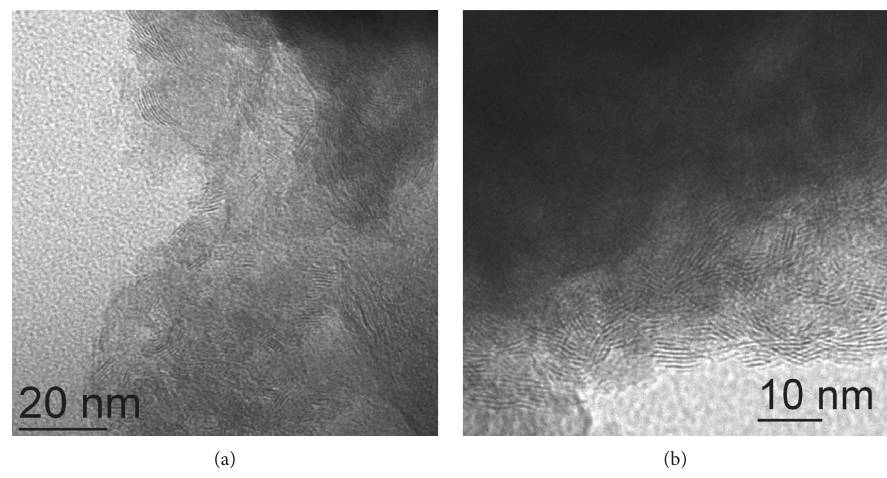
9 S 8 catalysts.